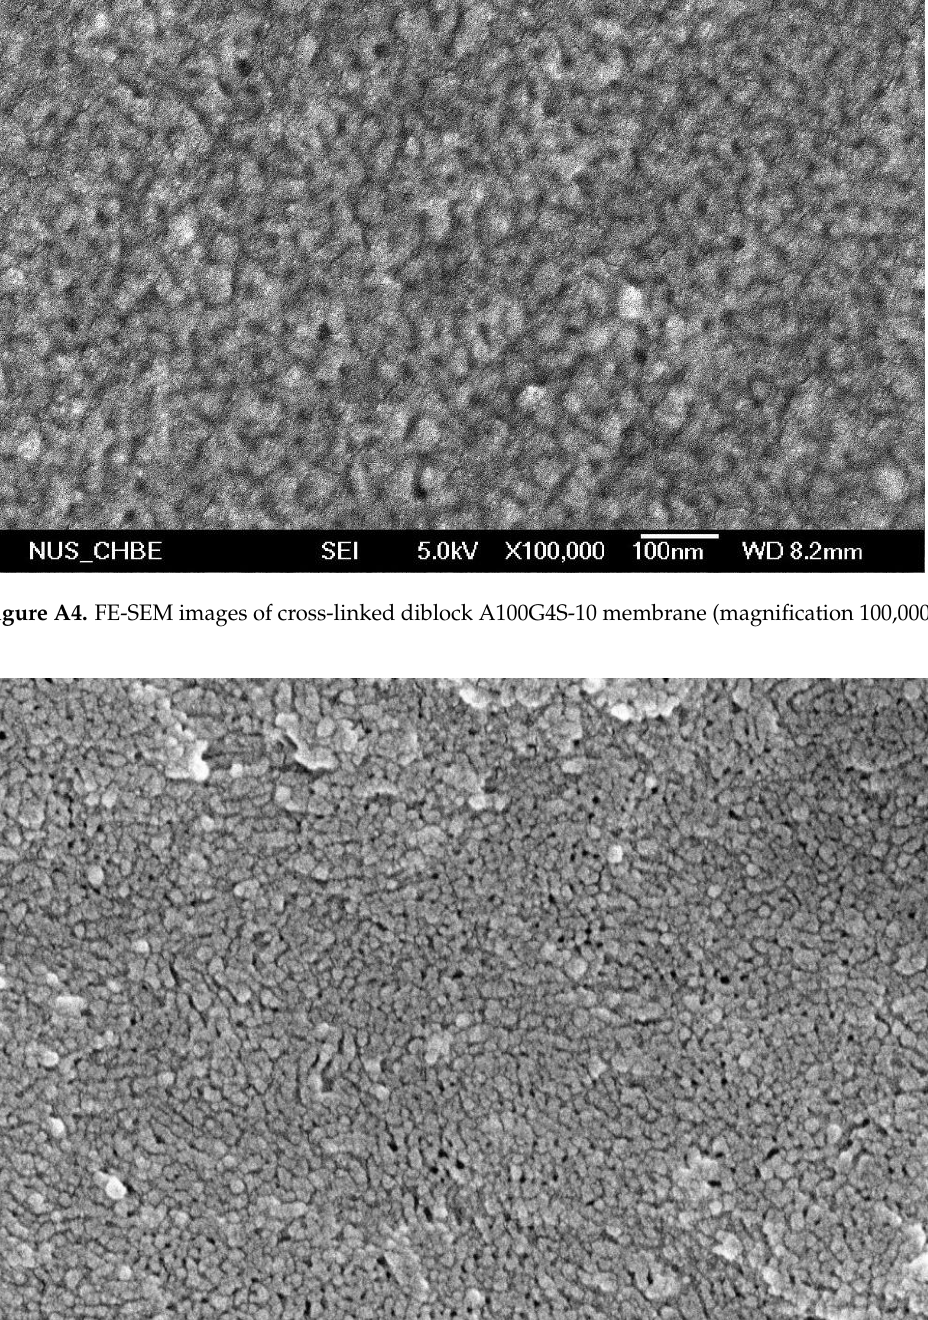
Figure A5. FE-SEM images of cross-linked diblock A150G4S-10 membrane (magnification 50,000×).